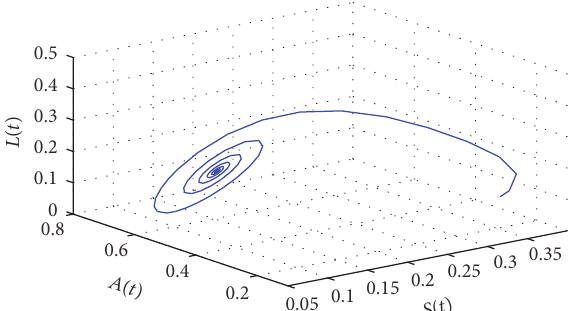
Figure 4: The phase plot of states 𝑆 ∗ , 𝐿 ∗ , and 𝐴 ∗ with 𝜏 1 = 29.49 > 28.4522 = 𝜏